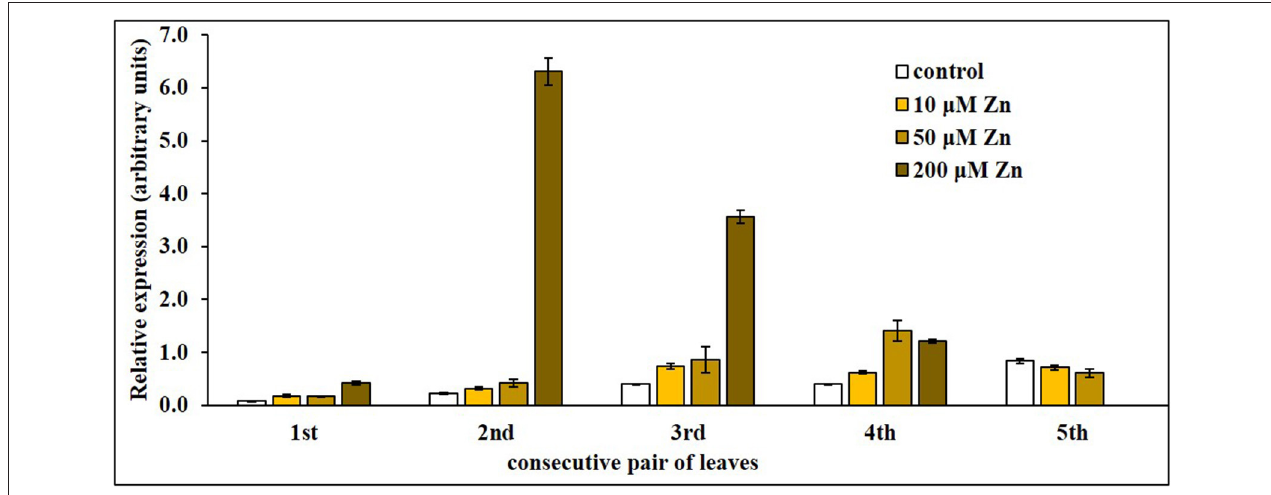
FIGURE 7 | NtNRAMP3 in consecutive pairs of leaves of plants grown under different zinc regimes. 5.5-week-old wild-type (WT) tobacco plants were transferred for the next 3 weeks to control medium ( ¼ Knop’s) supplemented with: (i) 10 µ M Zn; (ii) 50 µ M Zn; (iii) 200 µ M Zn. In parallel, WT tobacco plants were grown at control conditions. Expression of NtNRAMP3 was determined in consecutive pairs of leaves (numbered from 1 to 5; 1st and 2nd leaves counting from the base of the stem were the 1st pair, etc.). NtNRAMP3 transcript level was monitored by RT-qPCR and normalized to the NtPP2A expression level. Values correspond to mean ± SD ( n ≥ 3); those with a ratio > 2 are considered significantly different ( Jain et al.,